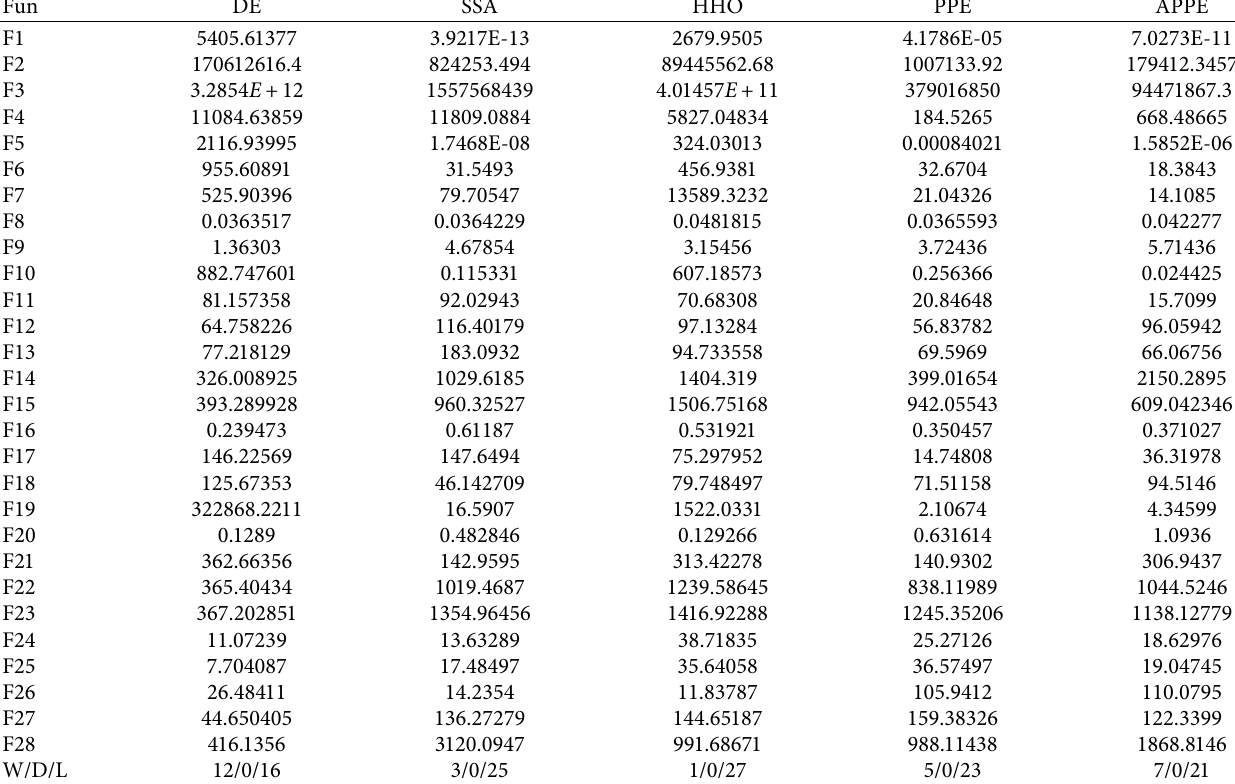
Table 12: Comparison of the standard deviation result of 51 runs on 50D in 28 benchmark functions.